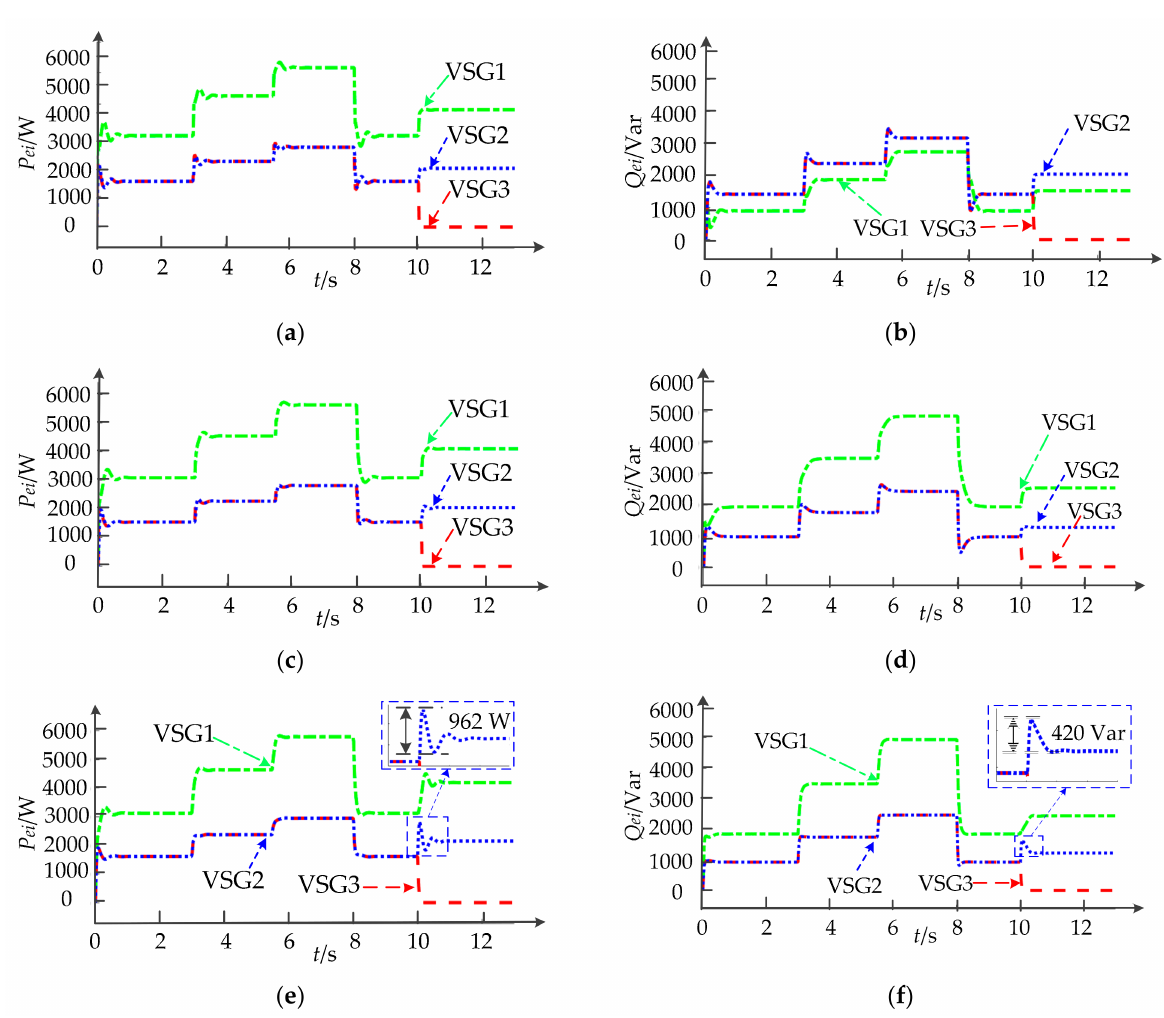
Figure 6. Power output waveforms of the VSG under different control strategies. ( a ) The traditional VSG control strategy outputs active power. ( b ) The traditional VSG control strategy outputs reactive power. ( c ) The improved control strategy outputs active power. ( d ) The improved control strategy outputs reactive power. ( e ) The integrated control strategy presented in the current study outputs active power. ( f ) The integrated control strategy presented in the current study outputs reactive